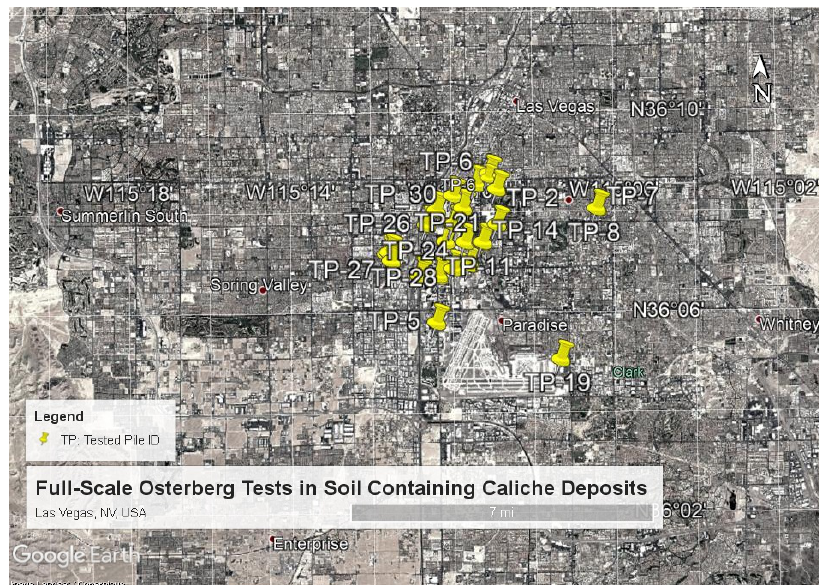
Figure 4. Location of the 30 reported bidirectional Osterberg tests. The full-scale tests were conducted in the presence of highly cemented caliche layers in the soil profile. Table 1. Geometries of the drilled shaft, caliche layers and reported bidirectional loads based on 30 Osterberg tests.